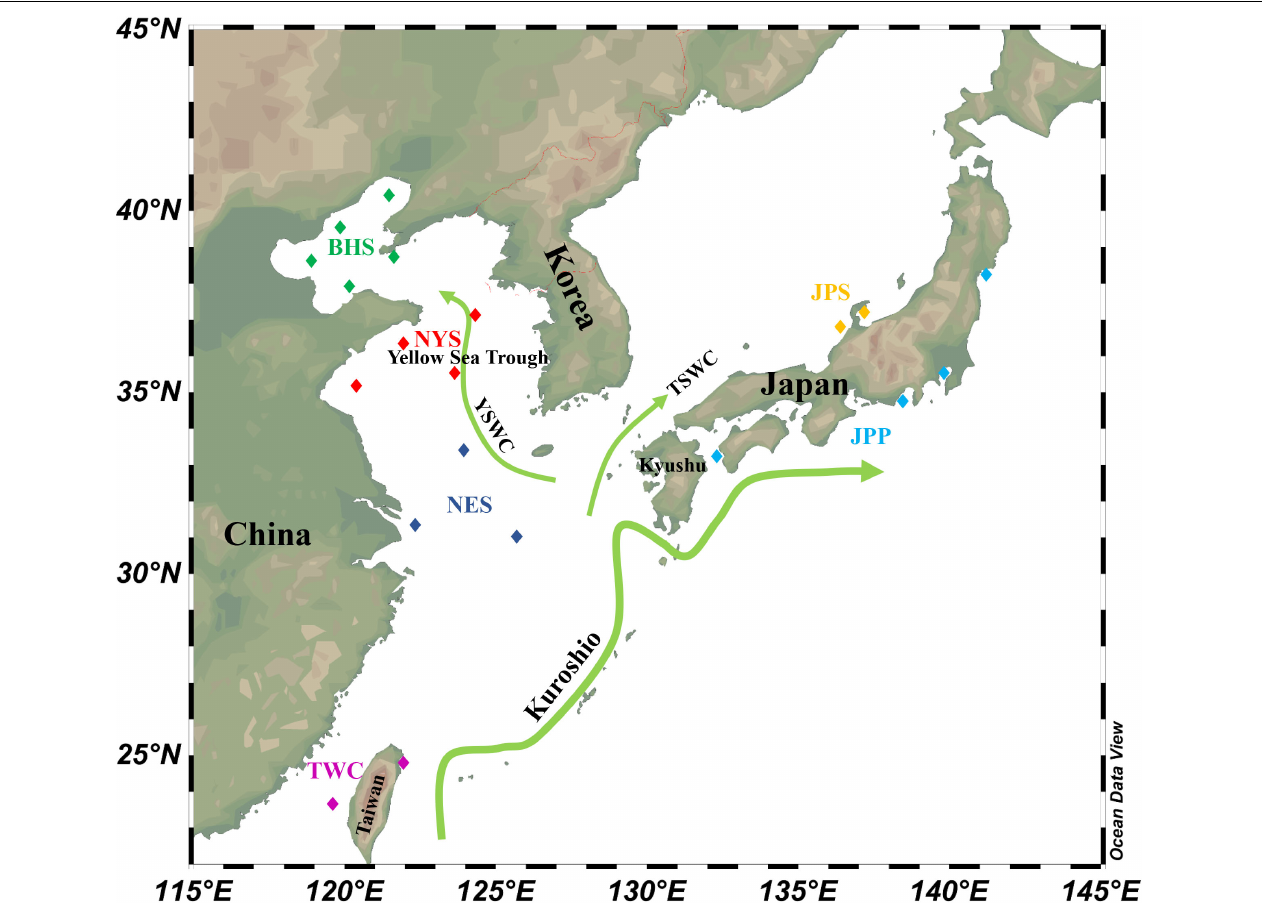
FIGURE 1 | Schematic map of ocean circulation in the northwestern Pacific. The green arrows denote the prevailing ocean currents. The rectangles represent individual sampling locations and rectangles with the same color represent each sampling regions of E. japonicus in the northwestern Pacific Ocean (Schlitzer,